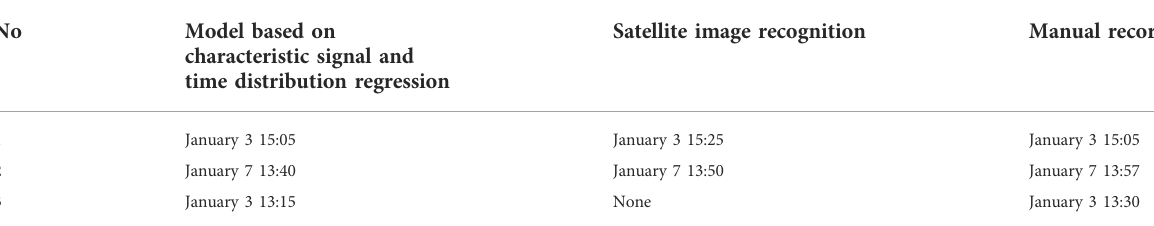
TABLE 7 Warning times.